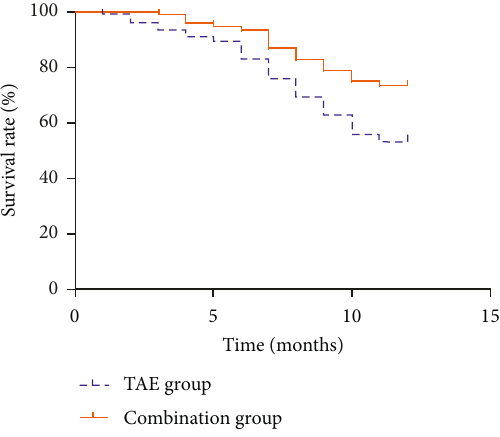
Figure 3: Comparison of 1-year overall survival rate between TAE group and combination group. Table 5: Comparison of in-hospital mortality, 1-year survival rate, and recurrence rate between the two groups ( n (%)). Group